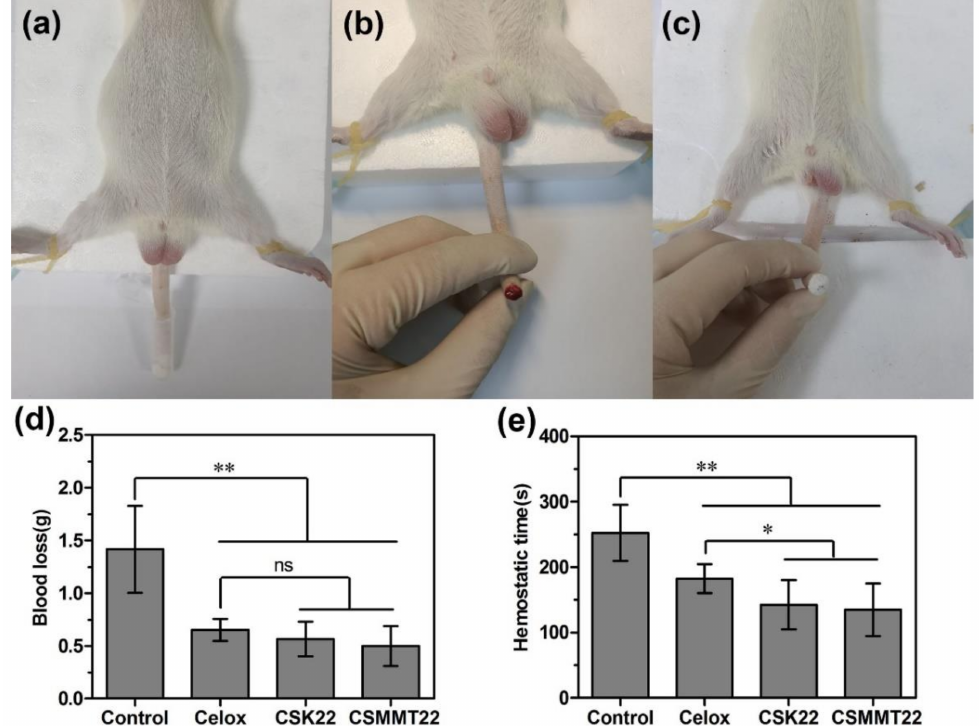
Figure 7. ( a ) Photographs of the rat tail amputation model, ( b ) amputation of tail to cause hemorrhage, ( c ) hemostatic effect by contacting the wound, ( d ) blood loss and ( e ) hemostatic time of control, Celox, CSK22, and CSMMT22. Data represent the mean ± SD ( n = 6). * p < 0.05; ** p < 0.01; ns p > 0.05, compared with the two